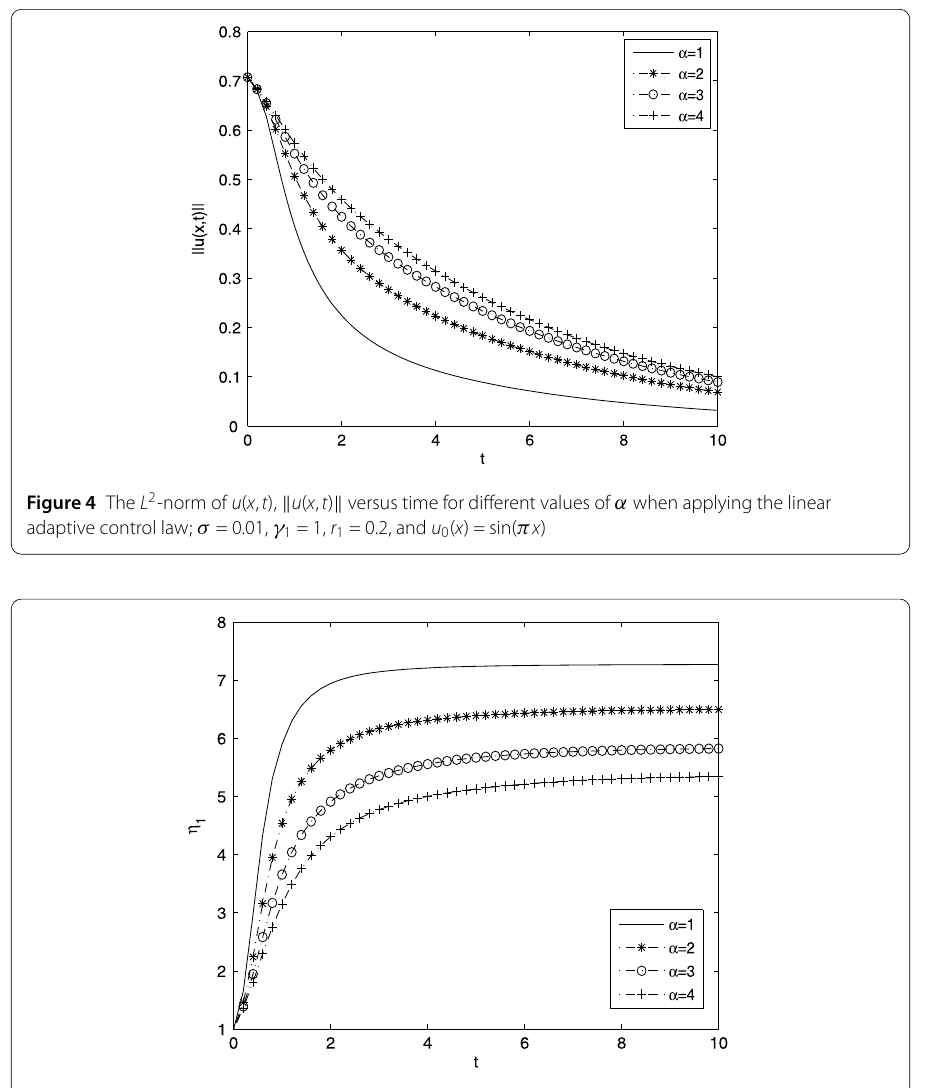
0.01 and 1, respectively. Moreover, r 1 is chosen to equal 0.2. The initial value of η 1 is